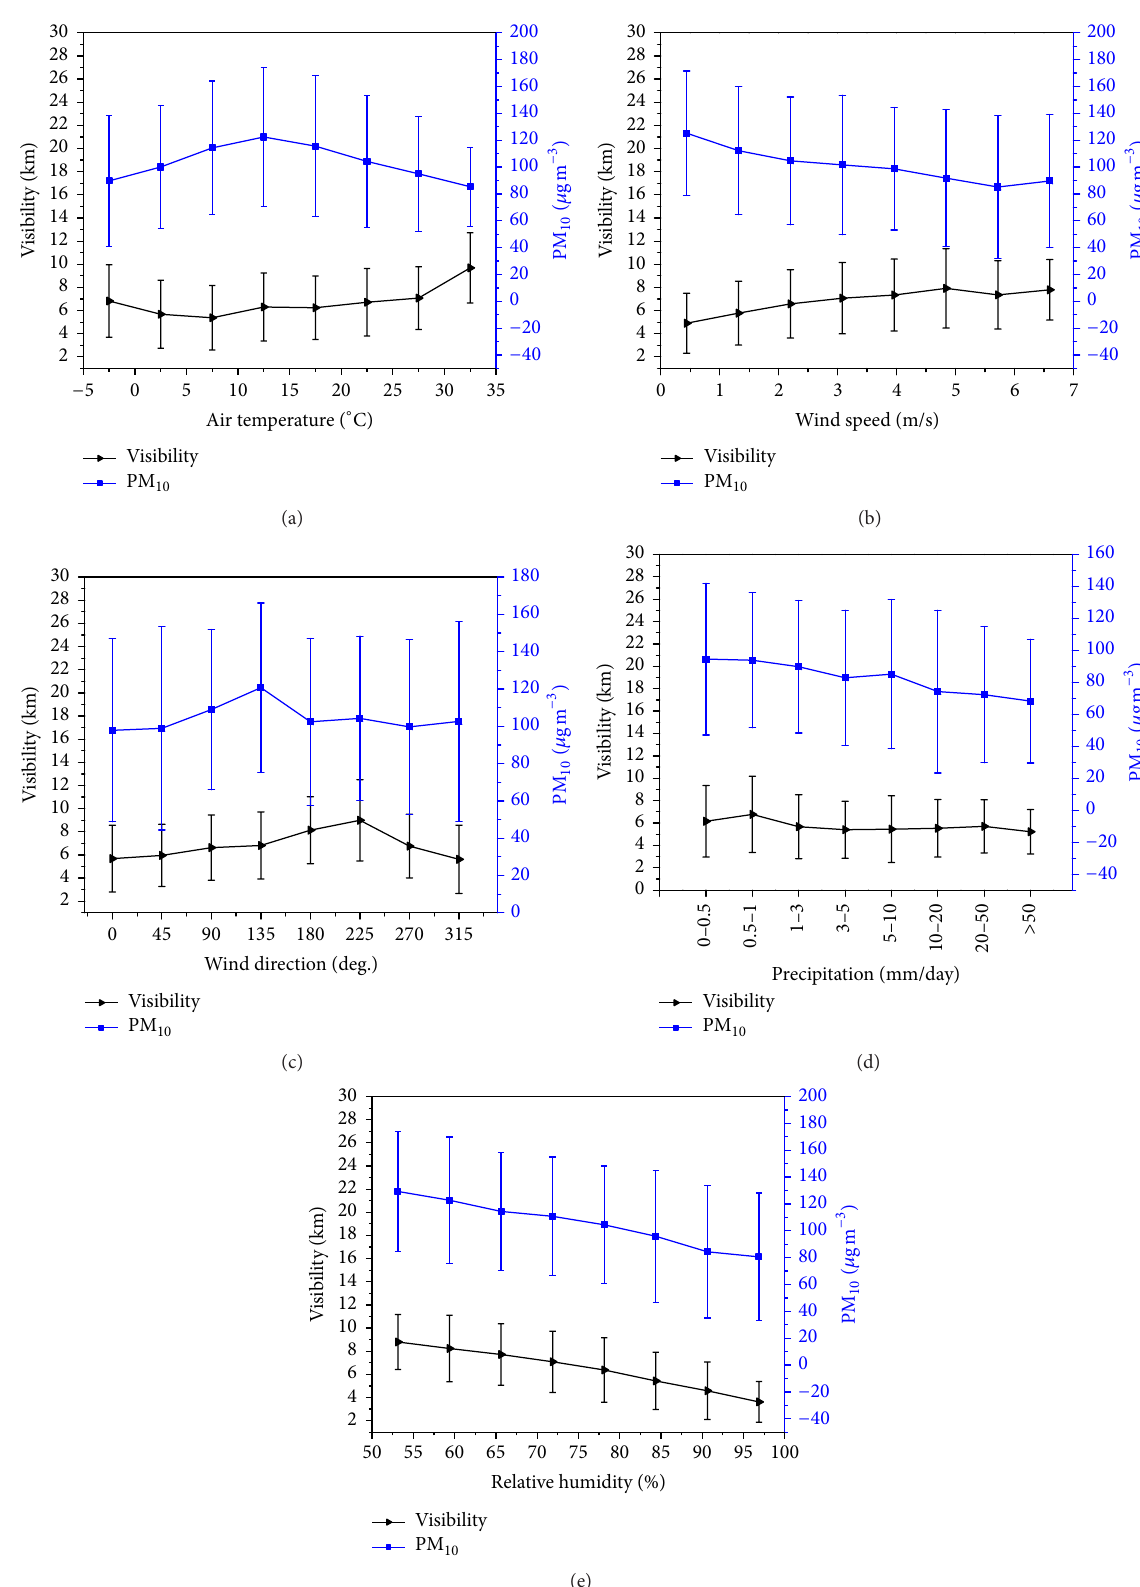
Figure 7: Effects of meteorological factors on PM 10 concentration and visibility in Hefei during 2001–2012: (a) air temperature, (b) wind speed, (c) wind direction, (d) precipitation, and (e) relative